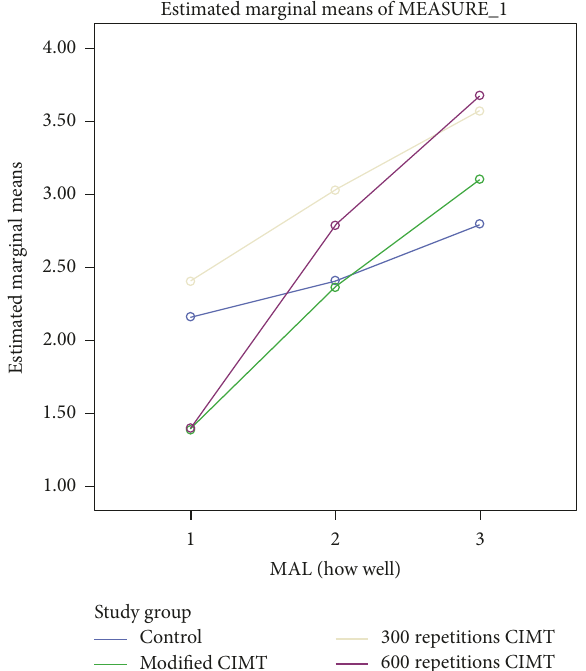
Figure 5: A profile plot showing groups’ mean scores in WMFT at baseline, 2 weeks, and 4 weeks after